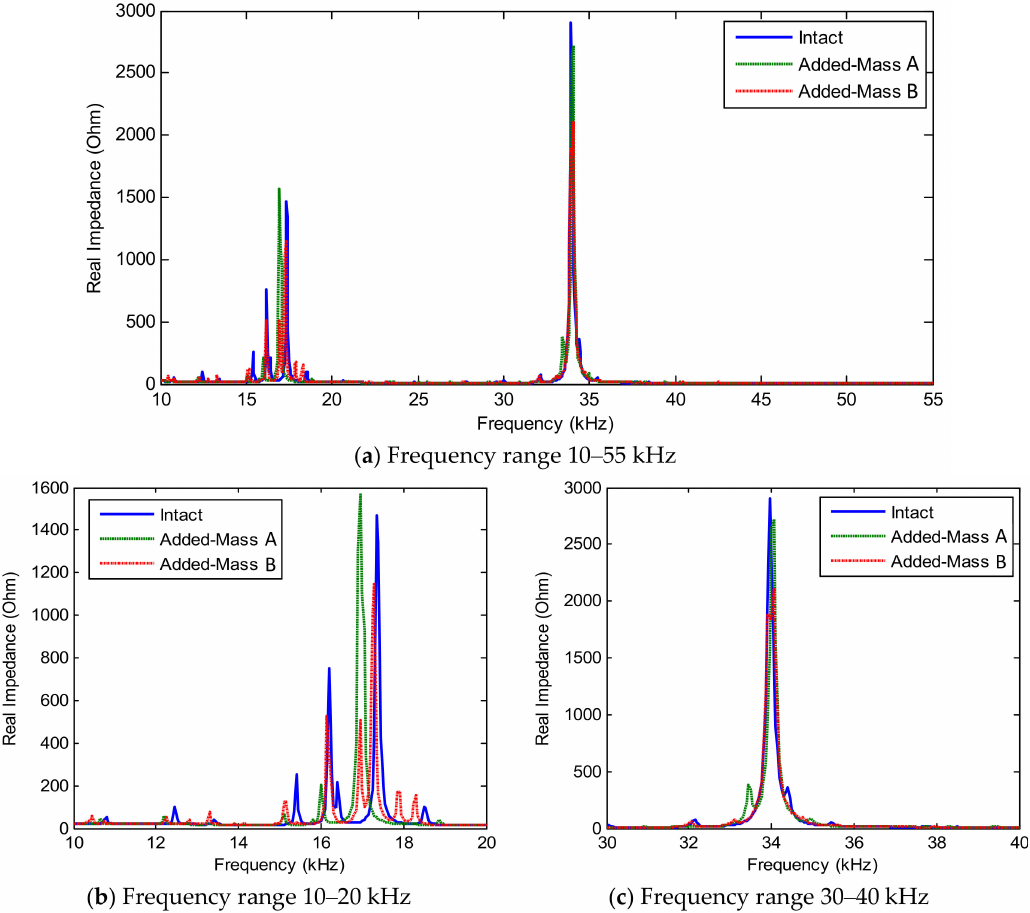
Figure 19. Variations in numerical impedance signatures of PZT interface under damage cases in connection splice